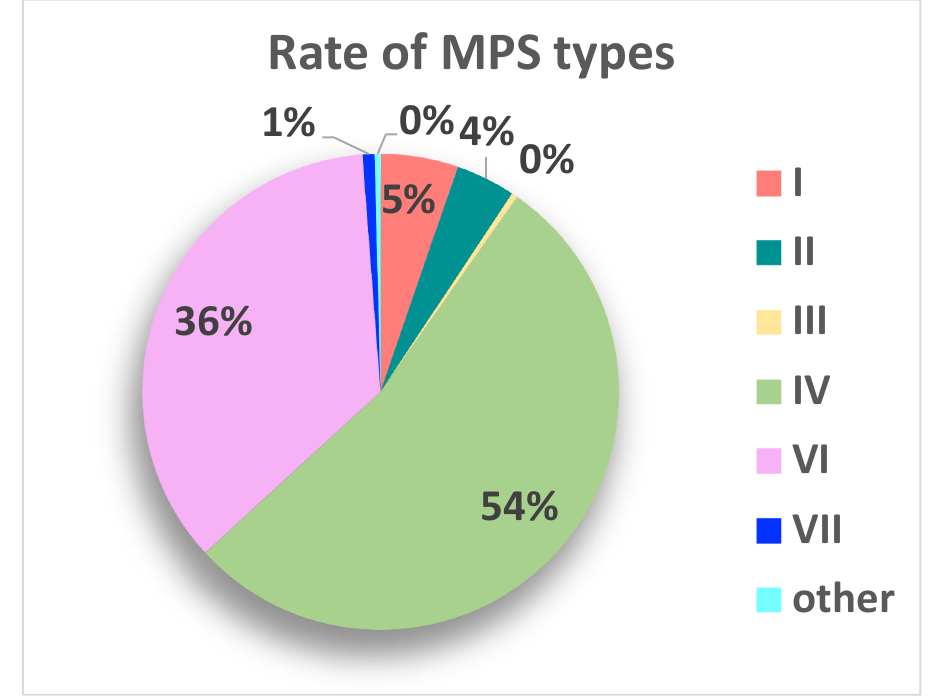
Figure 2. Rate of MPS type that is associated to cervical myelopathy (Other: one patient has an intermediate phenotype V/VI).